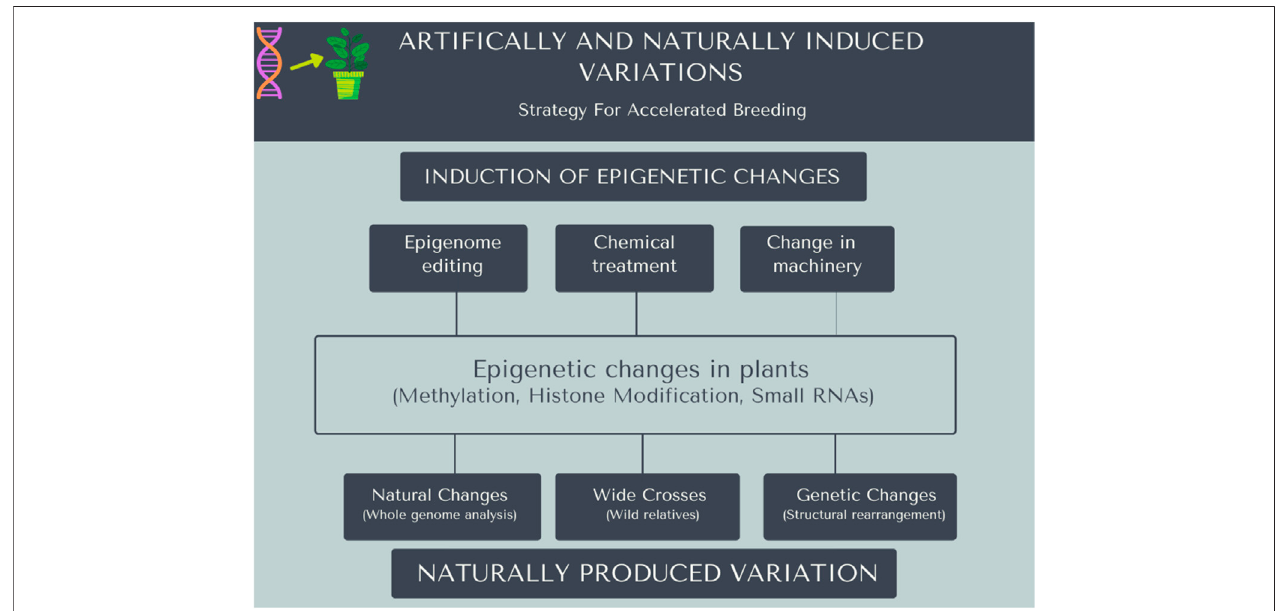
FIGURE 2 | Arti fi cially or naturally induced mutations in the plant genome can be helpful for accelerated breeding. Epigenetic changes can be induced in the plant genome using different methods, i.e., naturally or arti fi cially. Arti fi ciallyit canbe induced using editingtechniques,chemically treated plants to create mutations, and alter the machinery using different molecular approaches. Wide crosses of plants and naturally occurring changes in the genome in nature can be useful for accelerated breeding.